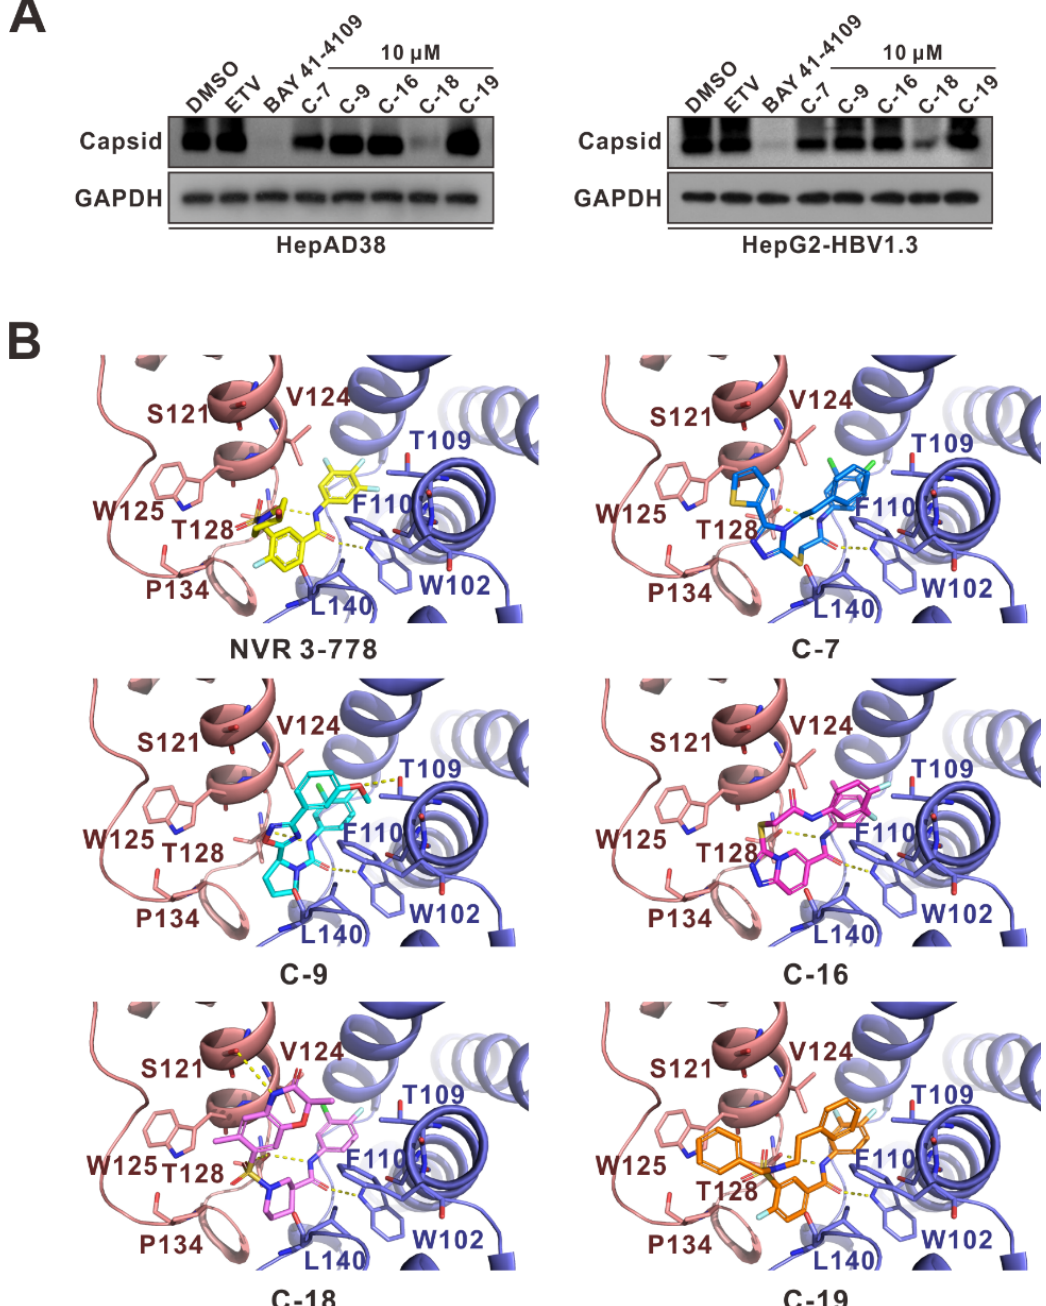
Figure 3. Effects of initial hits on viral particles and molecular interaction analysis. ( A ) Effects of five initial hits on intracellular HBV capsid formation. HepAD38 or HepG2-HBV1.3 cells were incubated with C-7, C-9, C-16, C-18, C-19 (10 μM), ETV (25 nM), or BAY 41-4109 (2 μM) for 6 days. HBV core particles were isolated from cell lysates by 1.2% non-denaturing agarose gel electrophoresis and immunoblotting. ( B ) Putative molecular interactions between HBV core protein dimers and NVR 3-778, C-7, C-9, C-16, C-18, or C-19. Compounds and residues were represented as sticks. Yellow dashed lines indicated the hydrogen bonds.